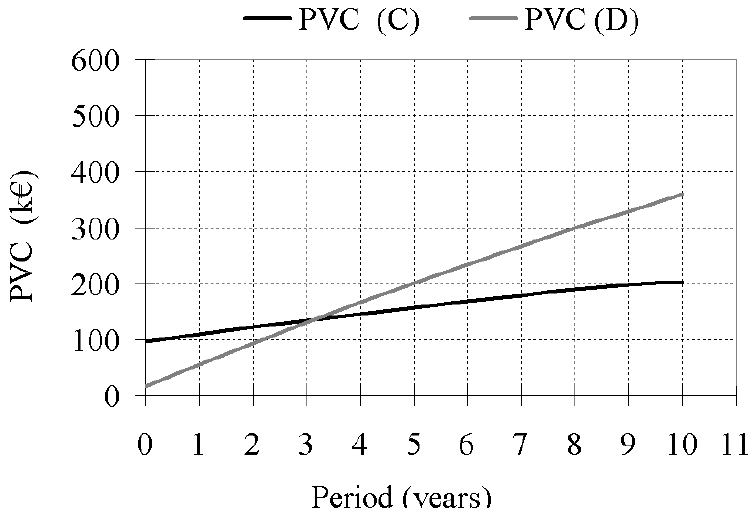
Figure 3. Variation of the Present Value of Costs (PVC) of the two heating systems (C = wood chips heating system; D = Diesel heating system) in relationship with the period duration.